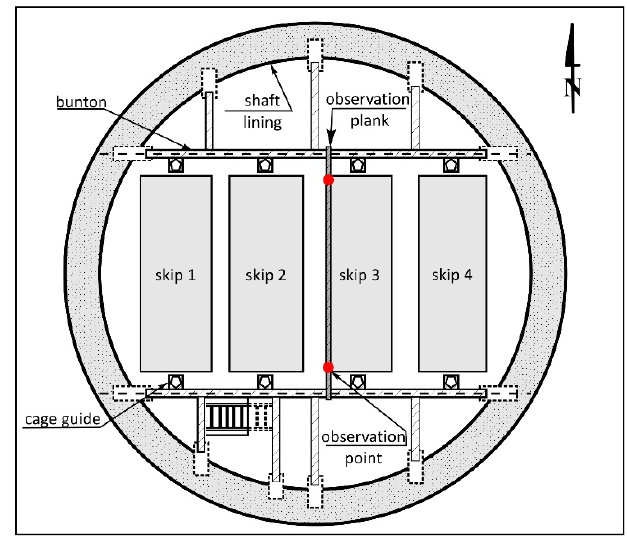
Figure 1. The mine shaft cross-section.